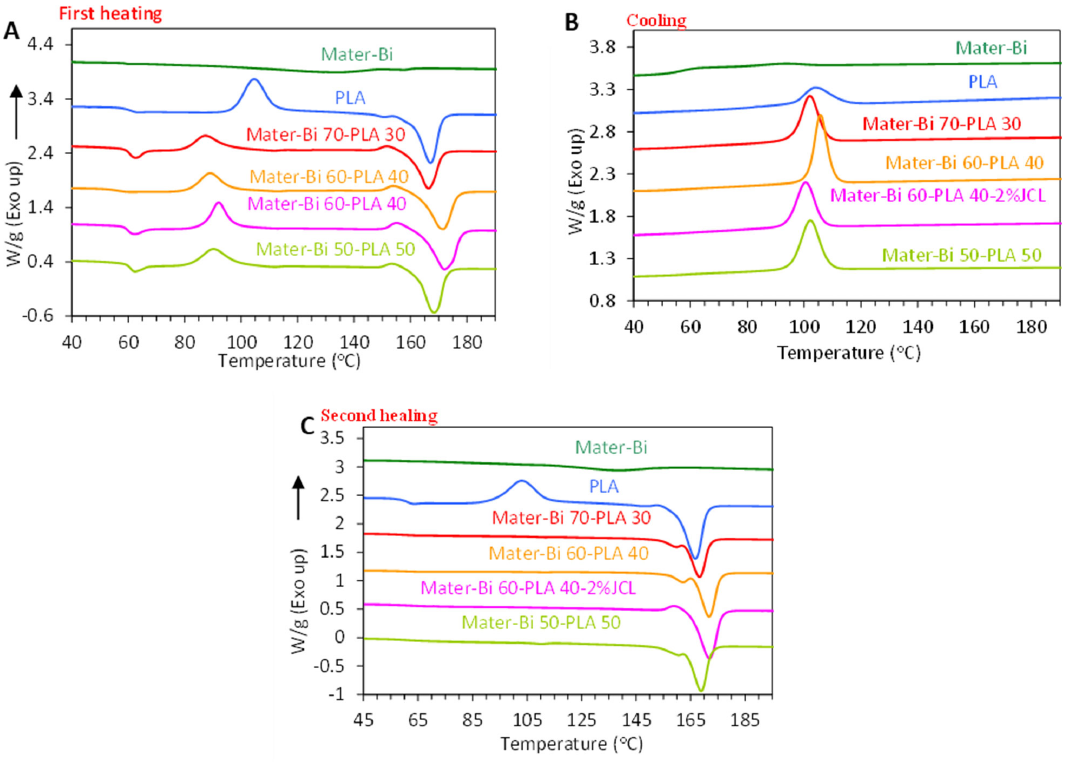
Figure 5. DSC curves of Mater ‐ Bi/PLLA blends during ( A ) first heating scan, ( B ) cooling scan, and ( C ) second heating scan. ( C ) second heating scan. Table 4. The main thermal properties of the different formulations of Mater ‐ Bi/PLLA related to the Table 4. The main thermal properties of the different formulations of Mater-Bi/PLLA related to the first scan. first